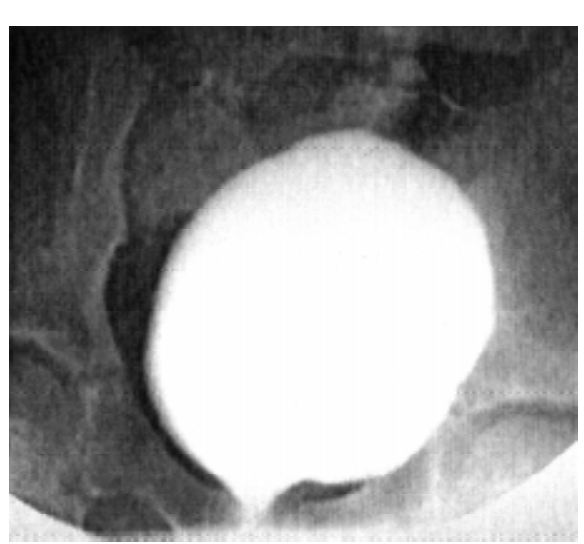
Figure 2 - Radiograph during the filling phase showing open bladder